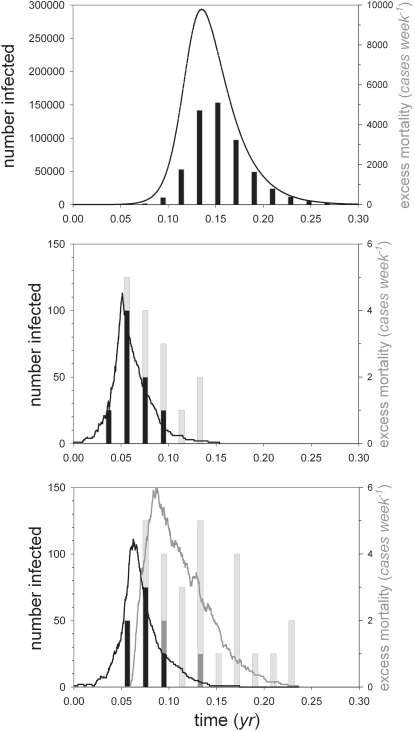
Simulations of an epidemic in a population of 106 individuals.The top panel shows the number of infected individuals (line) and mortality (bars) in the absence of an antiviral control program. The middle and bottom panel show simulations in case of a control program with an antiviral drug that provides complete (AVES = 1) and imperfect (AVES = 0.3, AVEI = 0.8) protection, respectively. Black bars refer to deaths caused by type 1 infection, grey bars to deaths caused by type 2 infections, and light bars to deaths caused by antiviral prophylaxis. The grey line in the bottom panel shows the number of infected individuals who were taking antiviral prophylaxis.